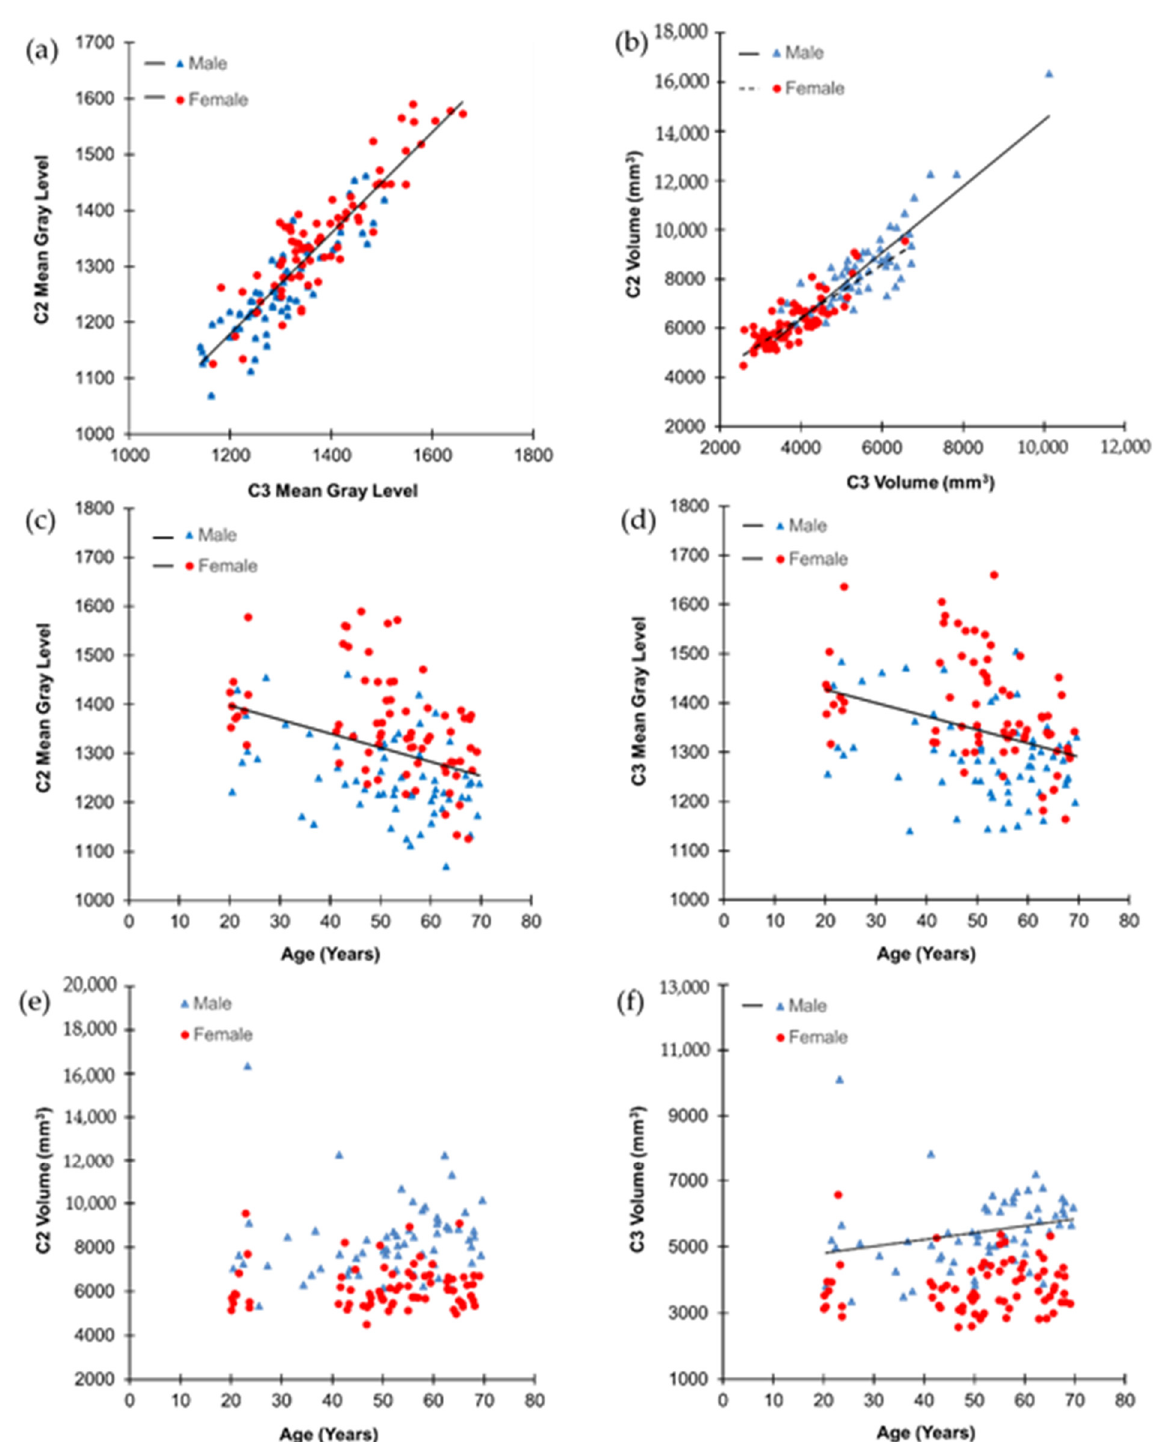
Figure 3. Correlations between C2 and C3 for ( a ) Mean gray level and ( b ) volume, and those of age with ( c ) C2 and ( d ) C3 Mean gray levels, and ( e ) C2 and ( f ) C3 volumes. The trend lines indicate a significant correlation ( p < 0.05). A significant interaction of sex on the correlation of volume between C2 and C3 ( p = 0.033) but not all other significant correlations ( p > 0.118). The values of Mean and volume had significant positive correlations with most of other gray level and morphological parameters of C2 and C3 in both male and female, respectively ( p <